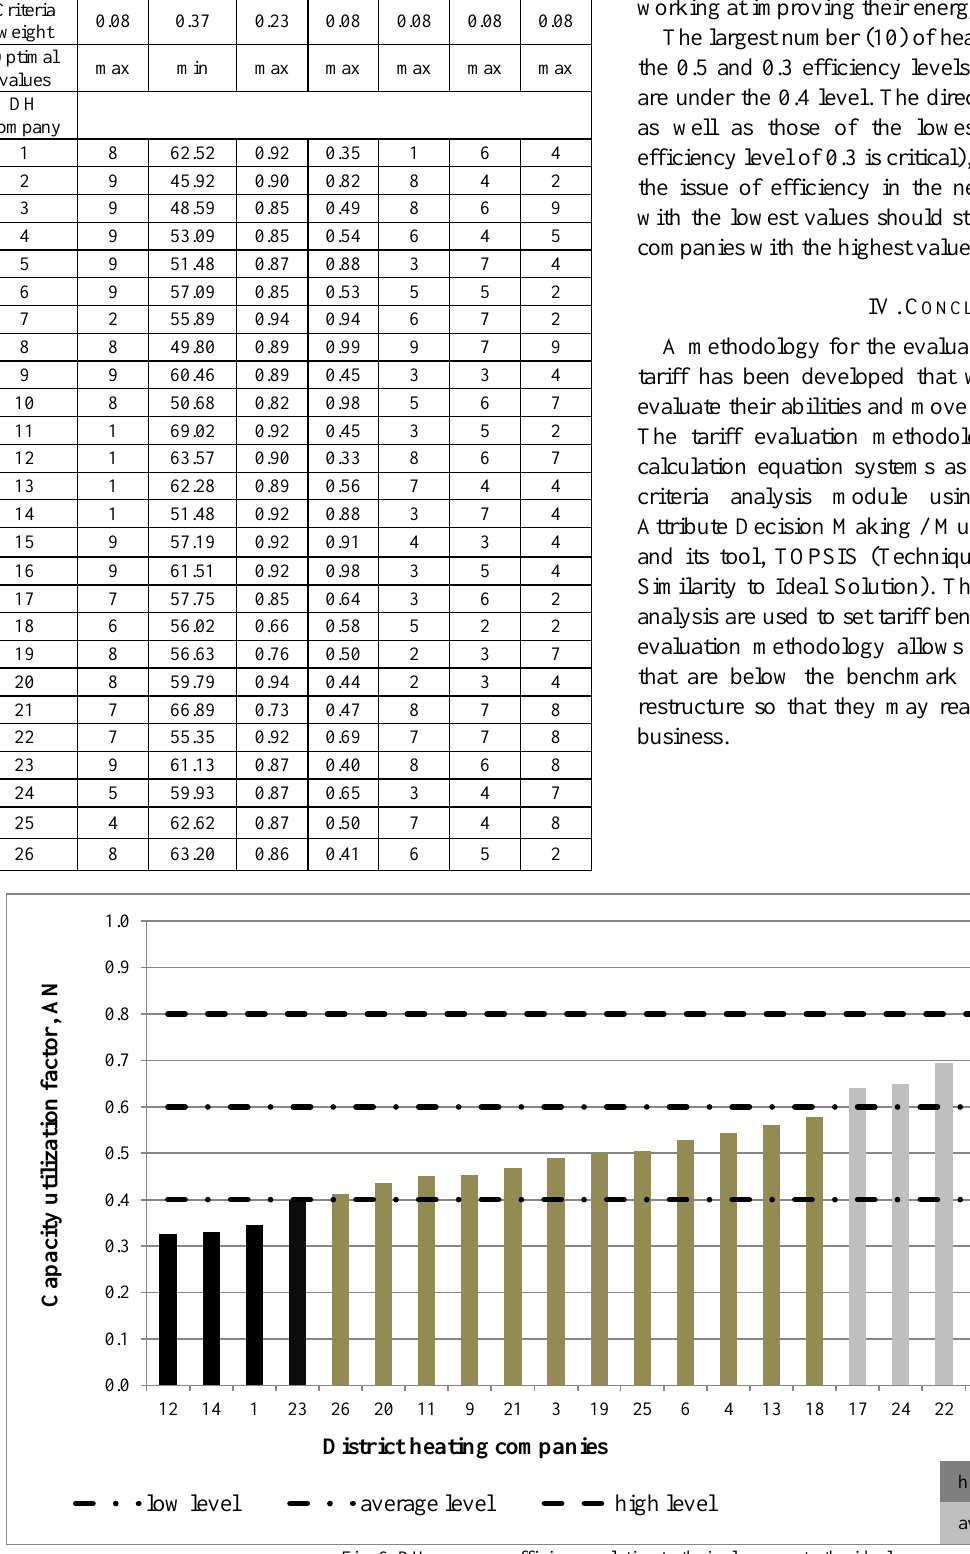
Fig. 6. DH company efficiency relative to their closeness to the